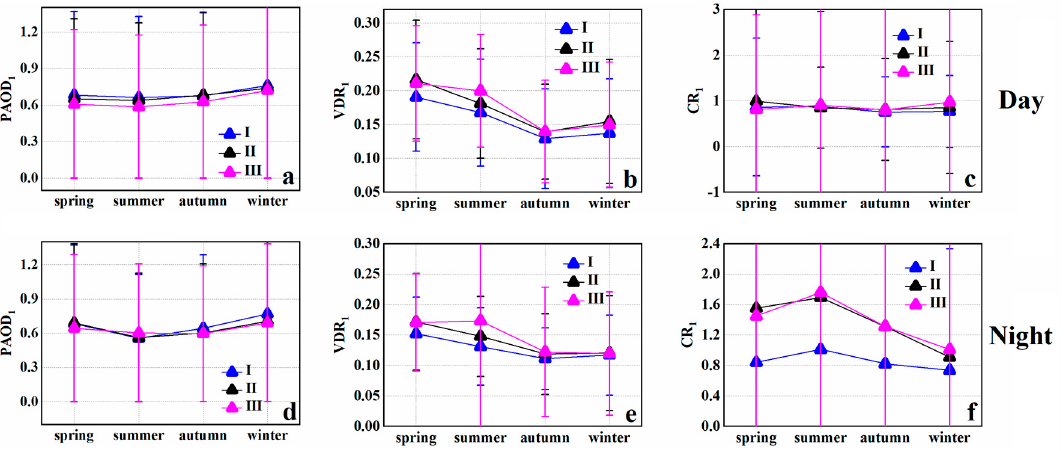
Figure 16. Seasonal variation in the optical and physical properties of aerosol layer over Saudi Arabia (regions I, II, and III) from 2007 to 2019. ( a , d ) represent PAOD 1 , ( b , e ) represent VDR 1 , and ( c , f ) represent CR 1 .